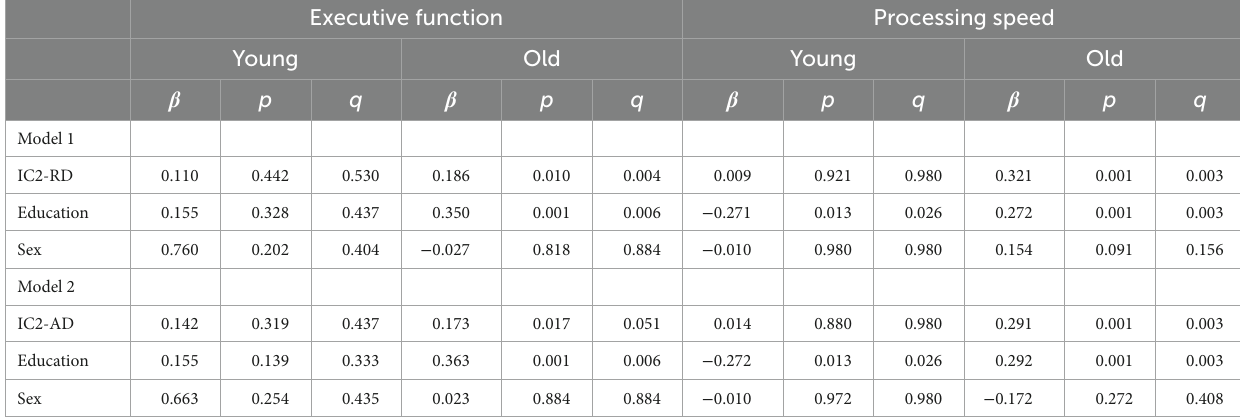
TABLE 2 Regression analyses of mixing coefficients for RD and AD as predictors of executive function and processing